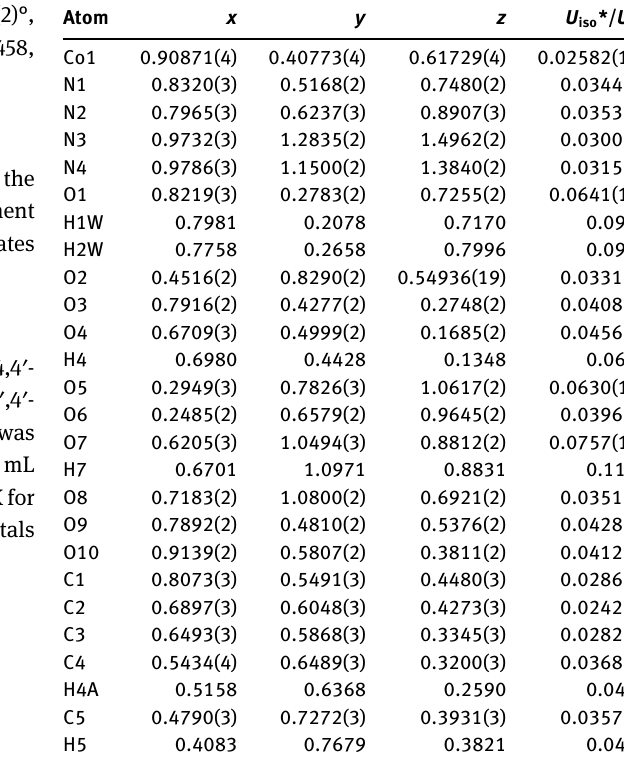
Table 2: Fractional atomic coordinates and isotropic or equivalent isotropic displacement parameters (Å 2